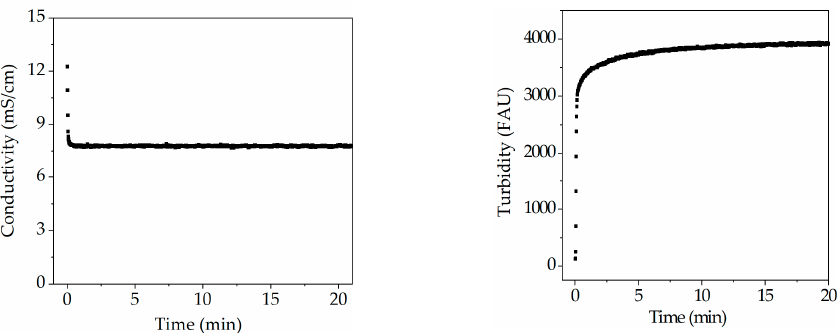
Figure 18. Course of conductivity, and turbidity probes during precipitation.